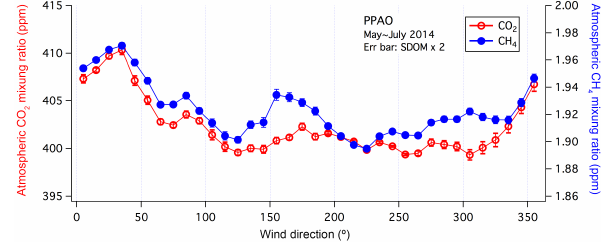
Figure 6. Atmospheric mixing ratios of CO 2 and CH 4 as a function of wind direction. Error bars indicate two standard errors within each wind direction bin. CO 2 and CH 4 mixing ratios were generally lower for south-westerly winds (180–240 ◦ ) than for northerly wind